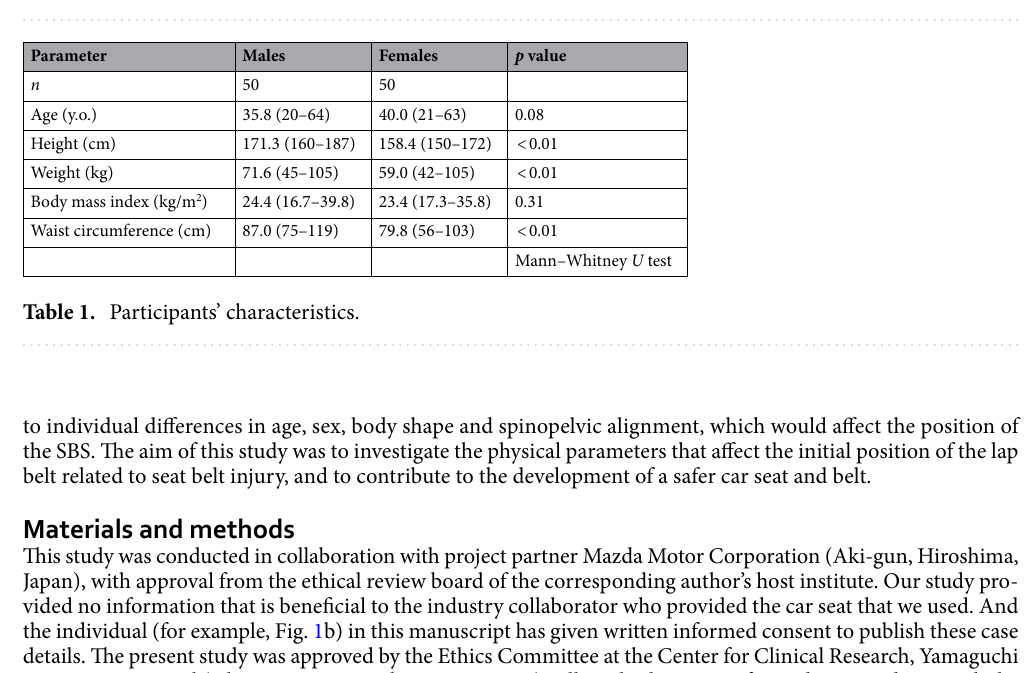
Figure 1. Histograms and standard deviations (SD) for age, height, weight, BMI, and WC are shown.